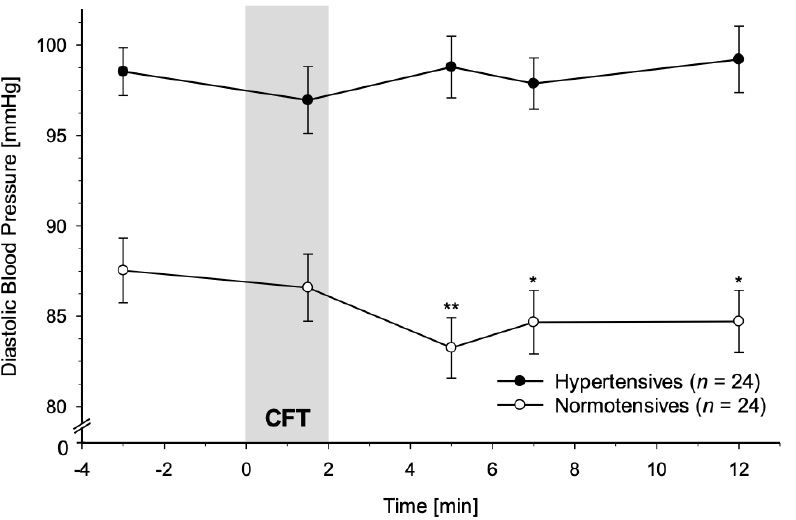
Figure 2. Diastolic Blood Pressure (DBP) response to Cold Face Test (CFT; grey bar) in hypertensive participants (black dots) and normotensive controls (white dots) (mean ± SEM). A repeated measures ANOVA revealed that hypertensives did not show DBP decreases after CFT-cessation as did normotensive controls (interaction group-by-time: p < 0.027). Repeated measures ANOVAs calculated separately in hypertensives and normotensives confirmed a significant main effect of time for DBP in normotensives ( p < 0.002), but not in hypertensives ( p = 0.59). Asterisks indicate significant differences between measurement timepoints during/after CFT and the respective baseline levels within each group (* p < 0.05; ** p < 0.01).